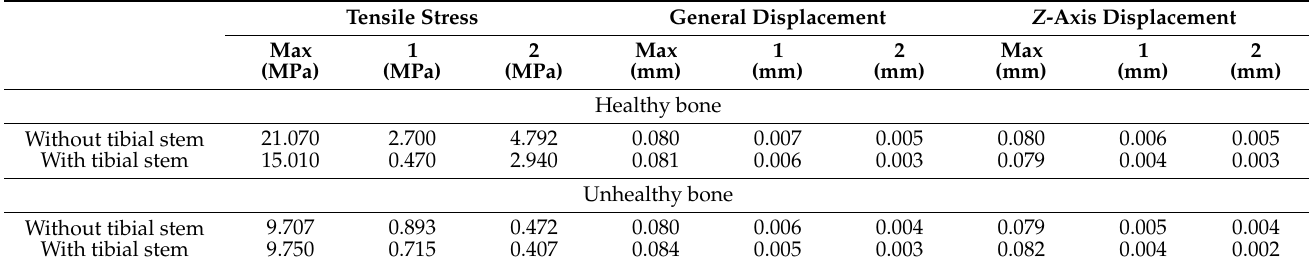
Table 5. Stress and displacement in linear compression dynamic